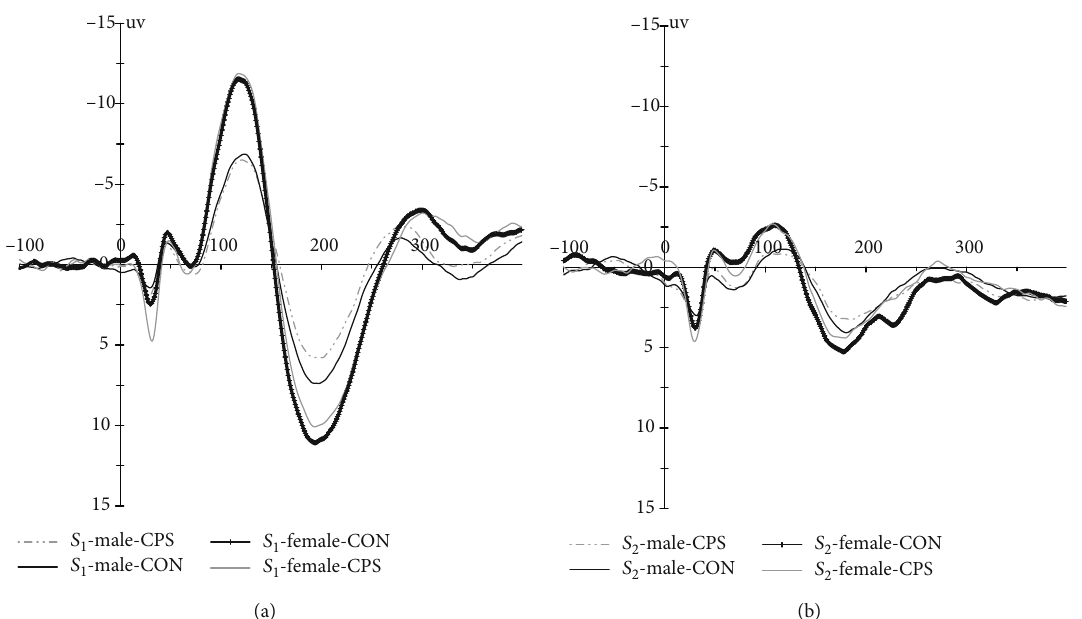
Figure 2: Grand averaged auditory evoked potential waveforms (C experimental sessions ( bandpass filter = 1 – 30 Hz